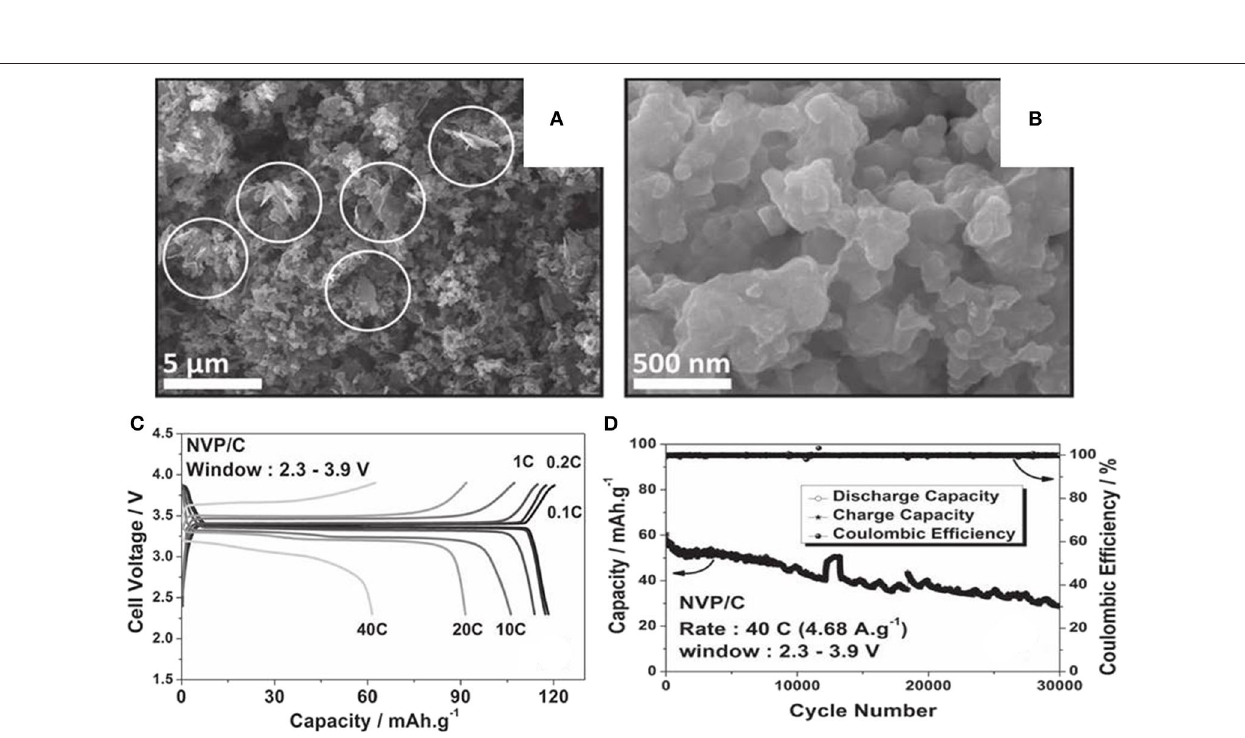
FIGURE 11 | (A) FESEM images at low, and (B) high magnification of NVP/C, (C) galvanostatic cycling of NVP/C at different current rates, (D) cycle property of the material cycled at a rate of 40C for 30,000 cycles.